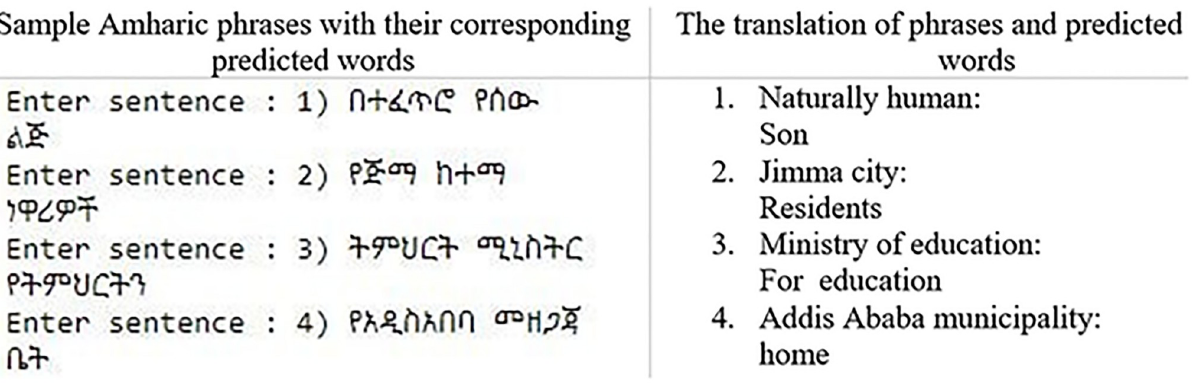
Fig 5. Sample predicted Amharic words from the provided phrase or sentence.